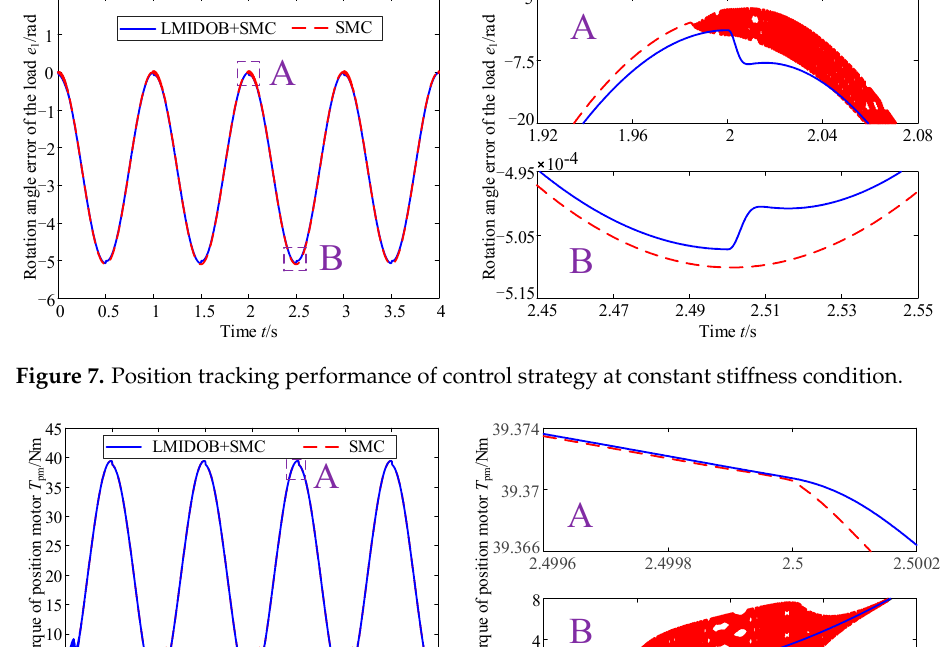
Figure 7. Position tracking performance of control strategy at constant stiffness condition.